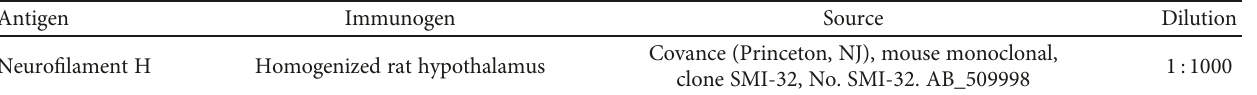
Table 1: Antibody